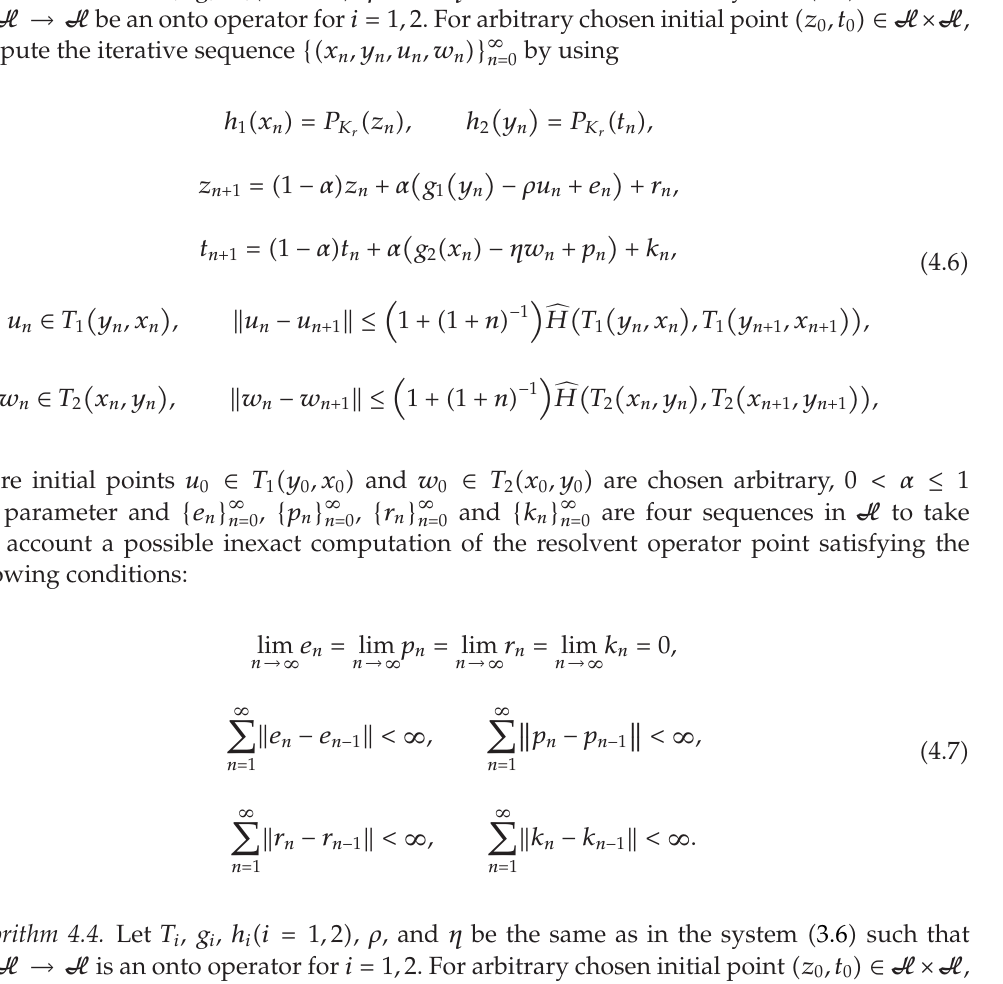
Algorithm 4.3. Let T i , g i , h i (cid:4) i (cid:8) 1 , 2 (cid:5) , ρ , and η be the same as in the system (cid:4) 3.1 (cid:5) such that